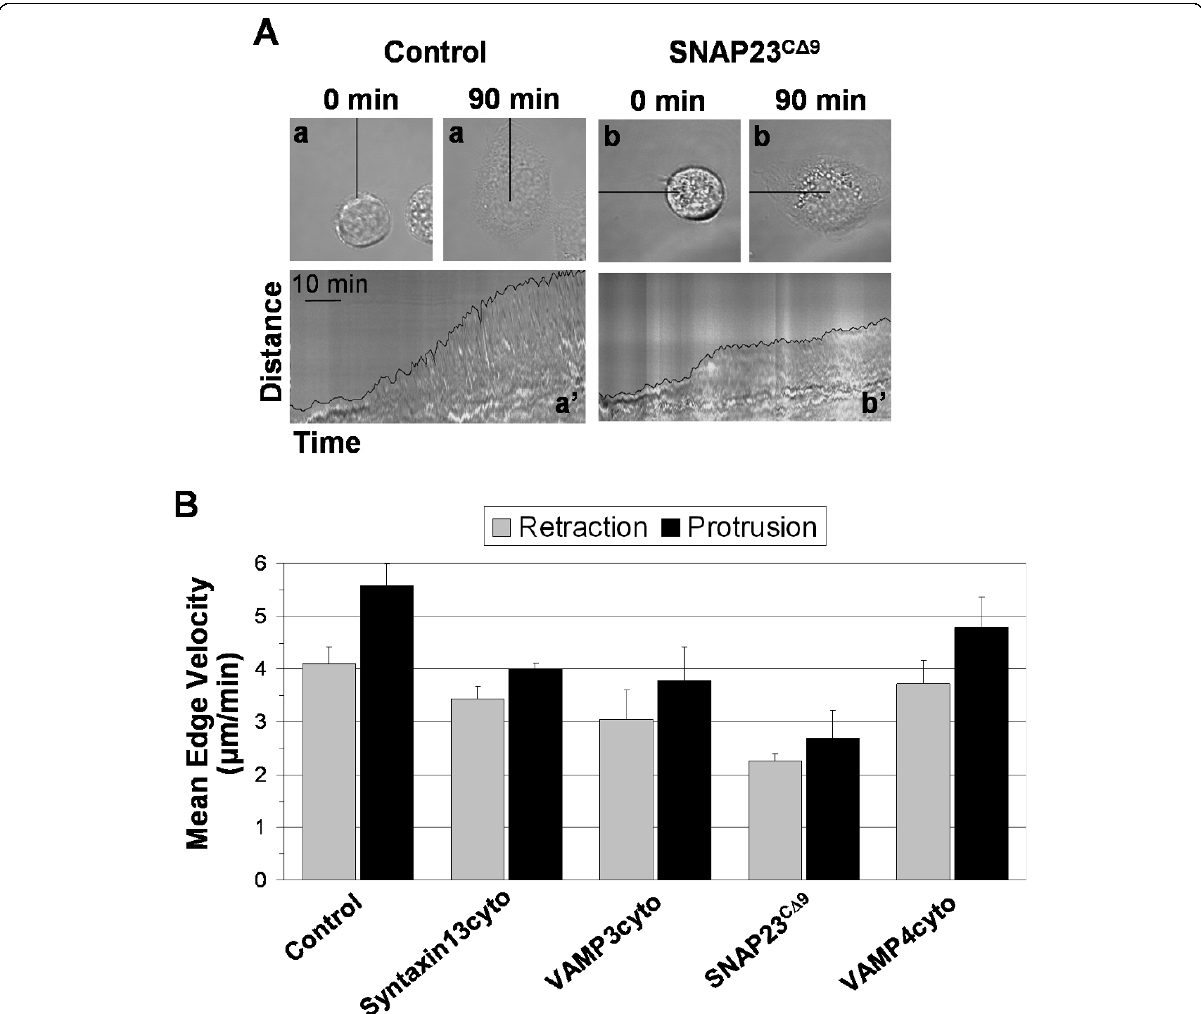
Figure 3 Inhibition of SNAREs reduces the rate of lamellipodium protrusion . Transfected CHO-K1 cells were plated in serum-free media on fibronetin for 90 min and monitored in real-time. (A) Representative control (a) and SNAP23 C Δ 9 (b) cells are shown at initial acquisition (0 min) and after 90 min (90 min) in the top panels. Kymographs (a ’ and b ’ ) in lower panels represent progression of the cell edge along the lines indicated with the cell edge highlighted. (B) The protrusion and retraction rate of the cell edge was determined from kymographs using ImageJ software. Data is presented as the mean velocity of immediate edge movement from at least two cell edges from at least 3 cells (when possible the most protrusive regions of the cell were